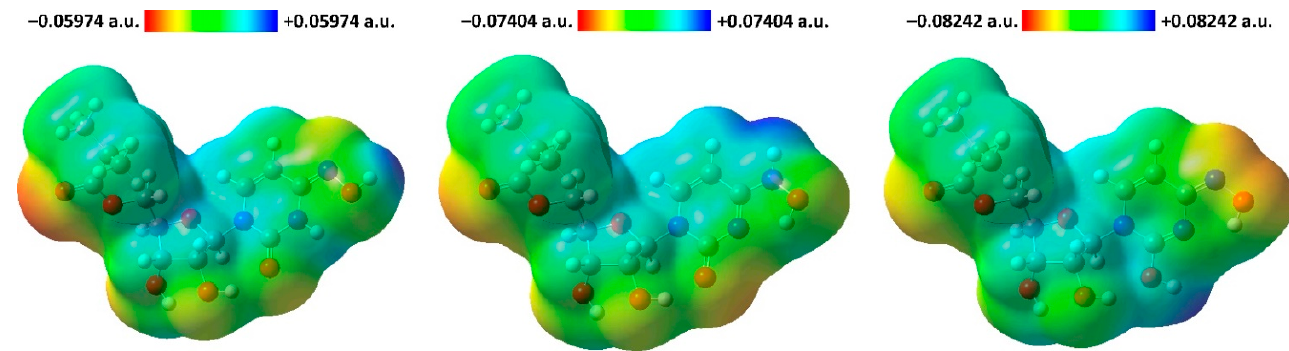
Figure 7. View of the molecular electrostatic potential surfaces of the optimized structures of the keto-oxime ( left ), keto-hydroxylamine ( middle ), and hydroxyl-oxime ( right ) tautomers of molnupiravir, obtained by using the B3LYP/6-311++G(d,p) method.